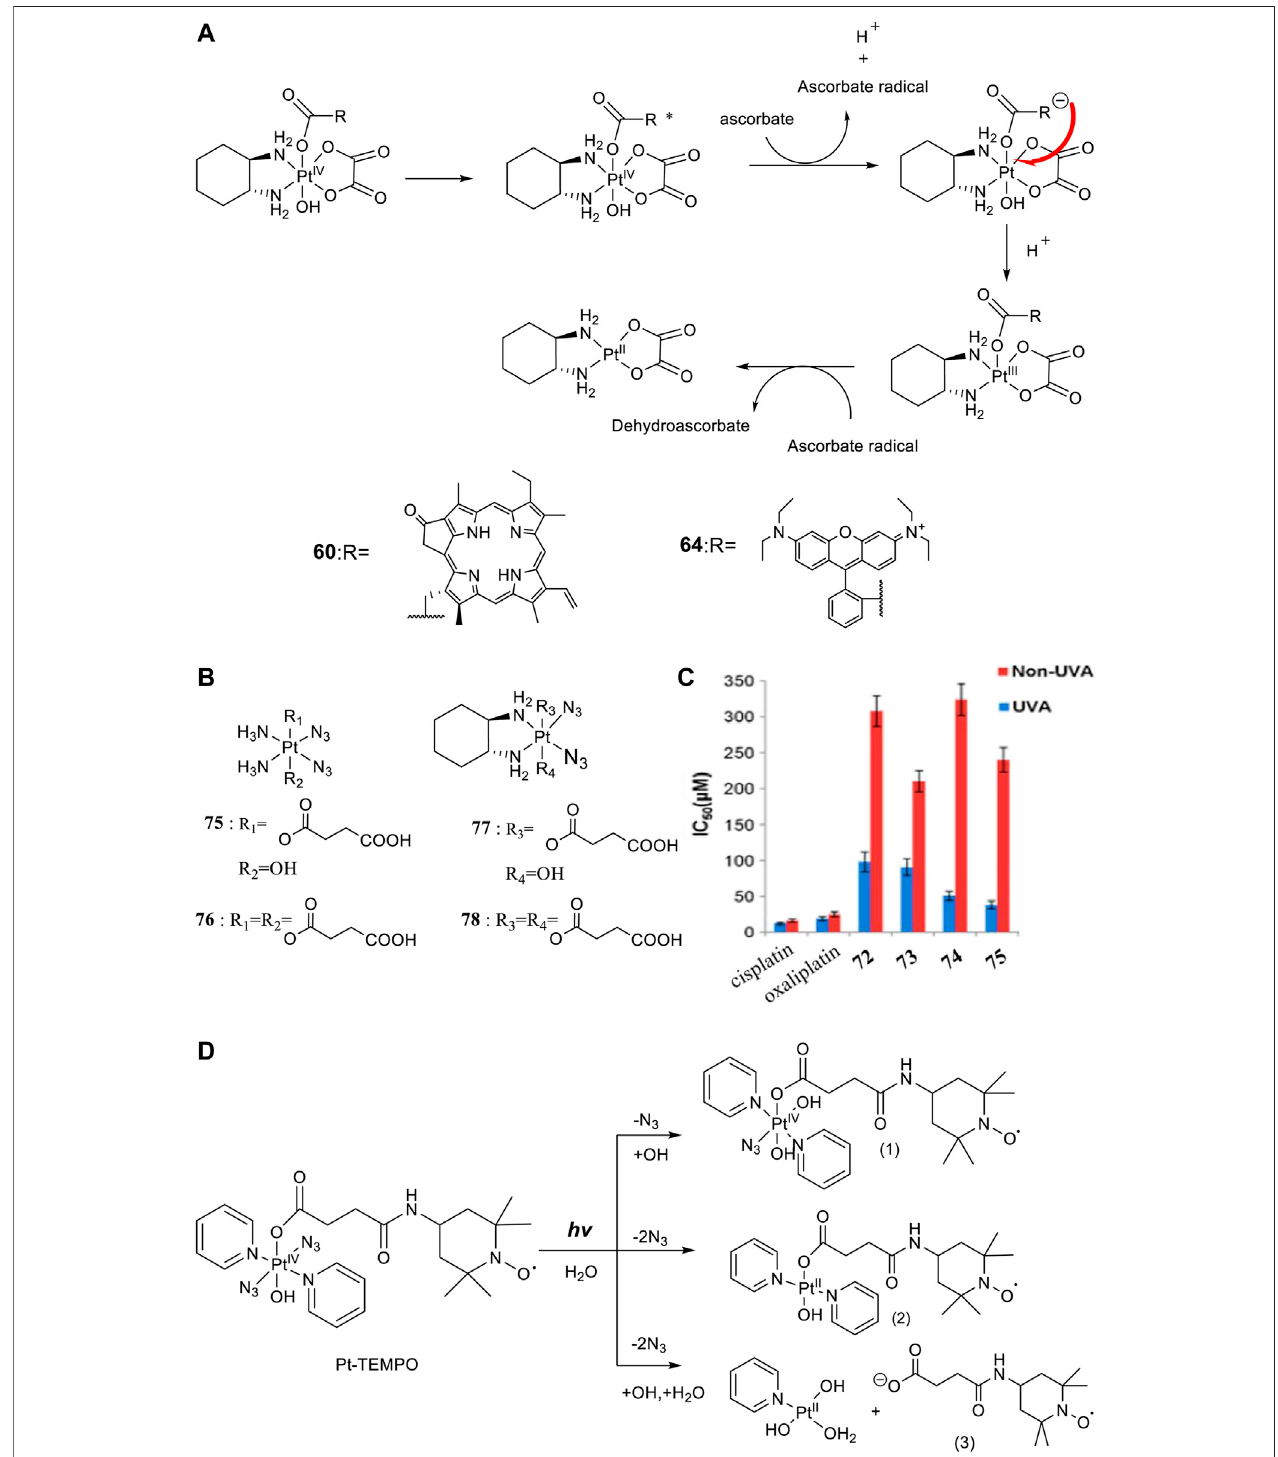
FIGURE 6 | (A) Proposed photoreduction mechanism of complexes 60 and 64 in the presence of ascorbate under physiological conditions (adapted from Wang et al. (2019); Deng et al. (2021)). (B) Chemical structures of complexes 75 – 78 . (C) IC 50 values of complexes 75 – 78 against SKOV-3 cells as determined by MTT assay [reproduced from Xiao et al. (2014)]. (D) Photoreaction pathways of Pt-TEMPO (0.1 mM) in H 2 O upon irradiation of blue visible light [adapted from Venkatesh et al. (2016)].